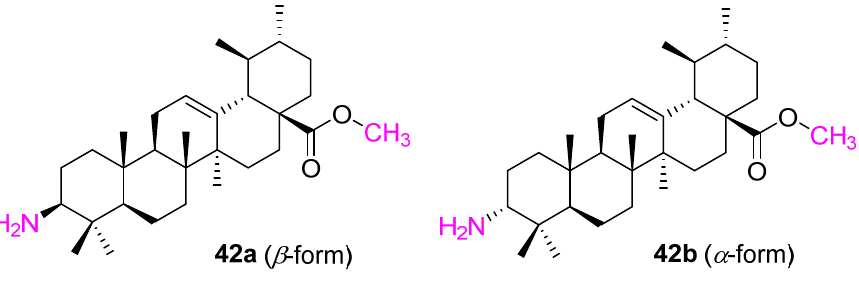
Figure 27. Structure of 42a , 42b .